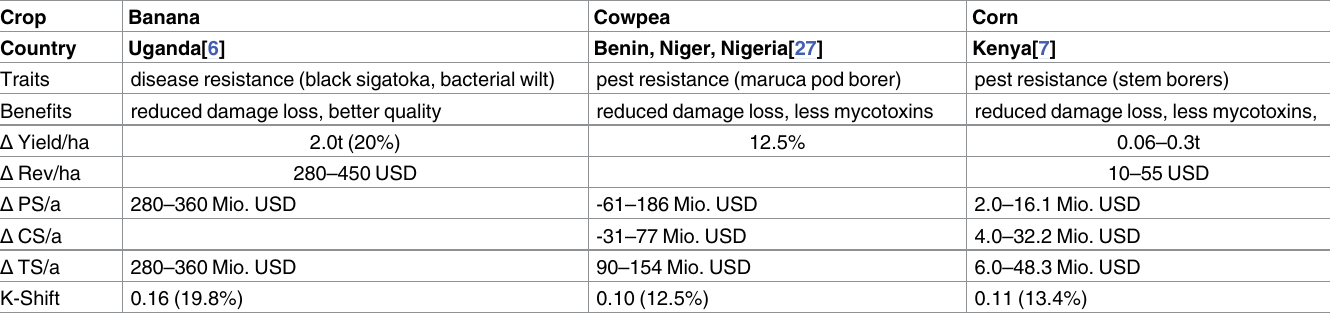
Table 2. Benefits and costs of GE crops considered. Crop Country Traits disease resistance (black sigatoka, bacterial wilt)